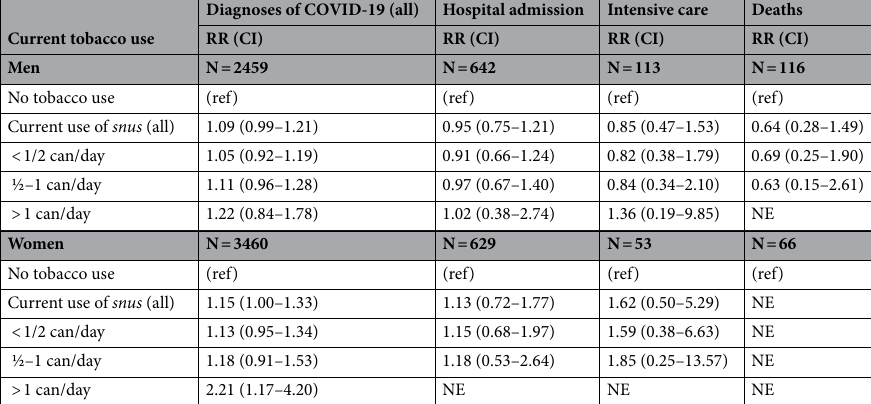
Table 4. Adjusted a Risk ratio (RR) and 95% Confidence Intervals (CI) of COVID-19 for current exclusive snus users compared to non-users of any tobacco among clients of the public dental clinics in Stockholm region (TOT-COH, N men = 169,488, N women = 205,831). NE not estimated because of the low number of events. a Adjusted for age (continuous), education, income (continuous), occupational risk, country of birth, and